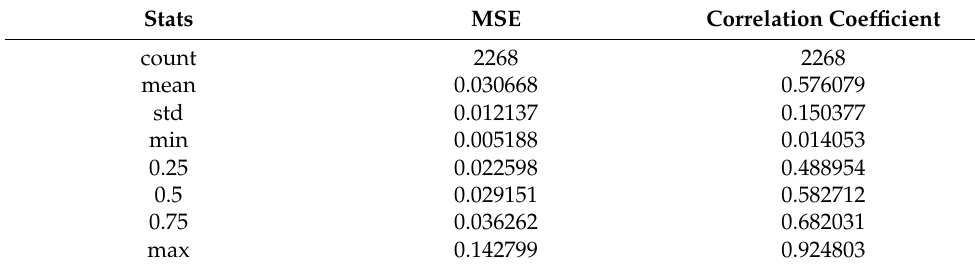
Table 2. Result summary of signal reconstruction from extracted features.